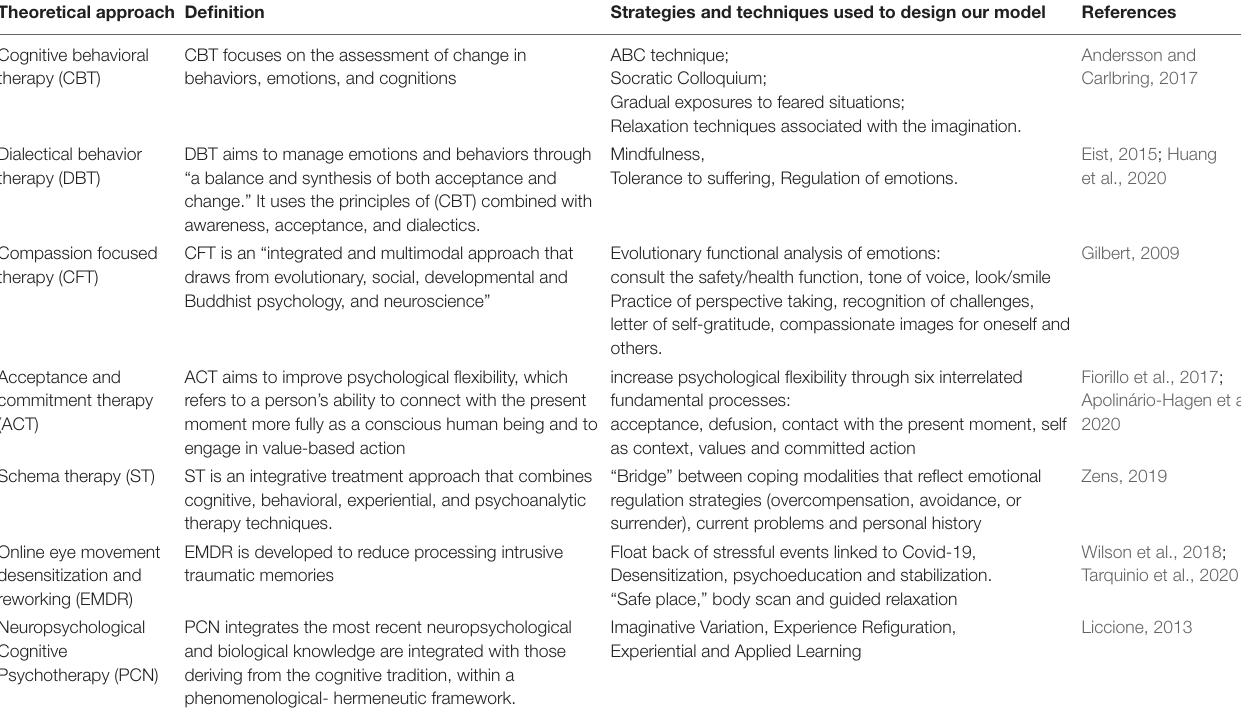
TABLE 2 | Psychotherapeutic approaches taken into consideration when designing our theoretical framework. Theoretical approach